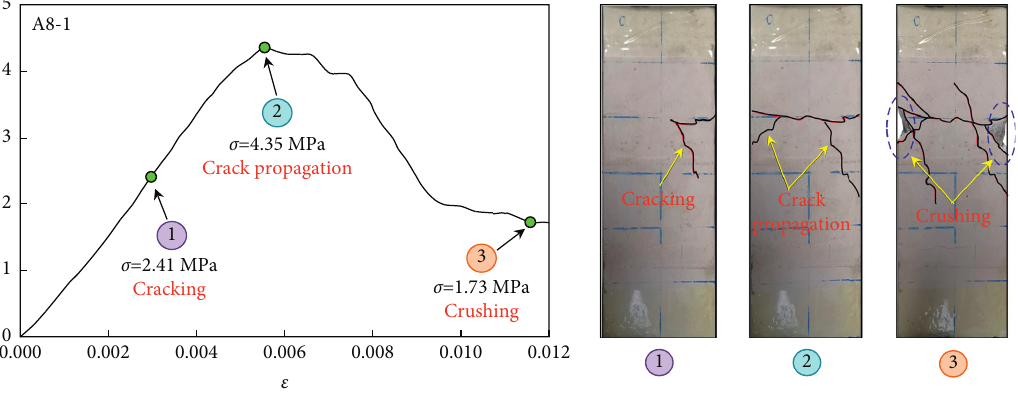
Figure 7: Failure process of specimen